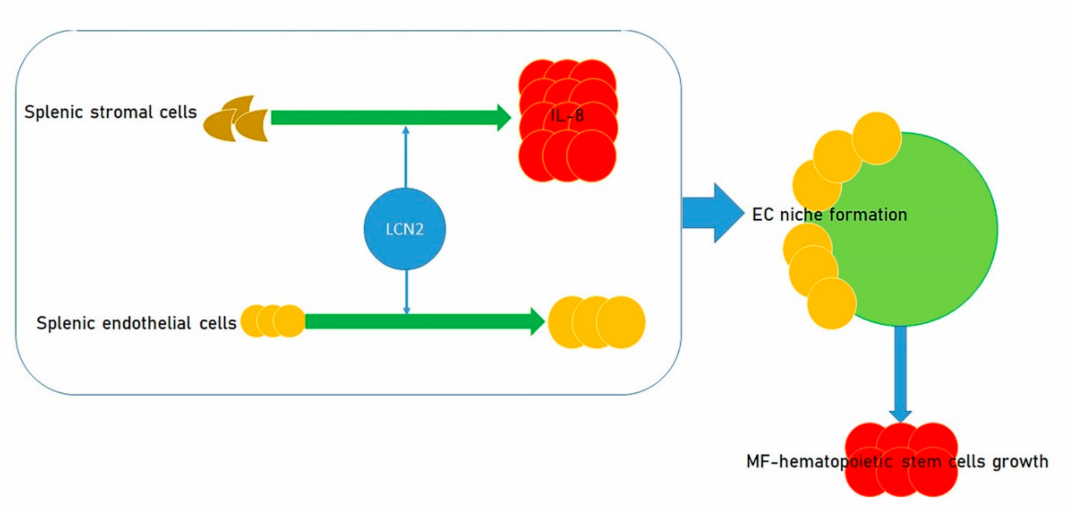
Figure 1. E ff ect of LCN2 on the growth of myelofibrosis (MF) hematopoietic stem cells. LCN2 fosters the growth of splenic endothelial cells, causing the enhanced production of IL-8 by splenic stromal cells. Such an increase plays a role in the formation of an endothelial cell niche, which, in turn, promotes the growth of myelofibrosis hematopoietic stem